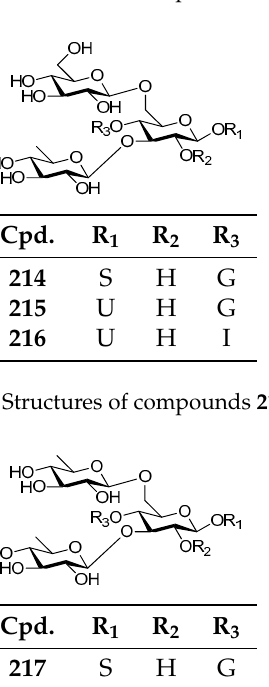
Figure 35. Structures of compounds 217 – 218 . Figure 36. Structure of compound 219 .